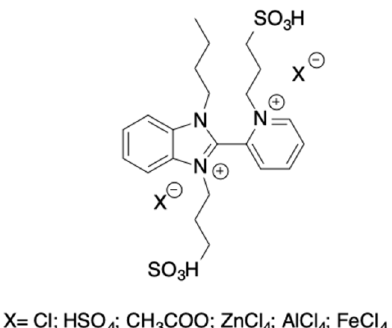
Scheme 18. Structure of the asymmetric dicationic TSILs.